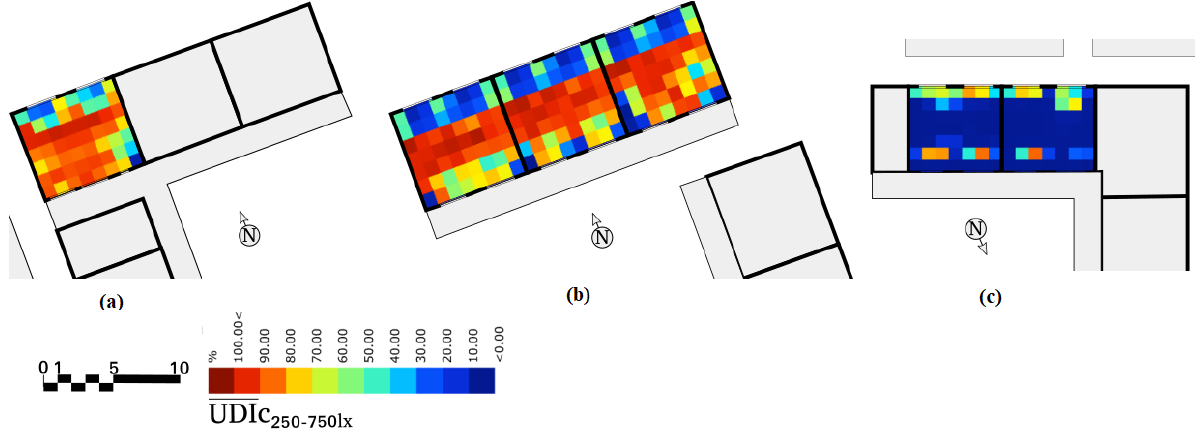
Fig. 3. The highest UDI c 250 − 750 lx objects in (a) category G, SDN 14 A3 FL 1, (b) category S, SDN 13 B FL 1 and the lowest